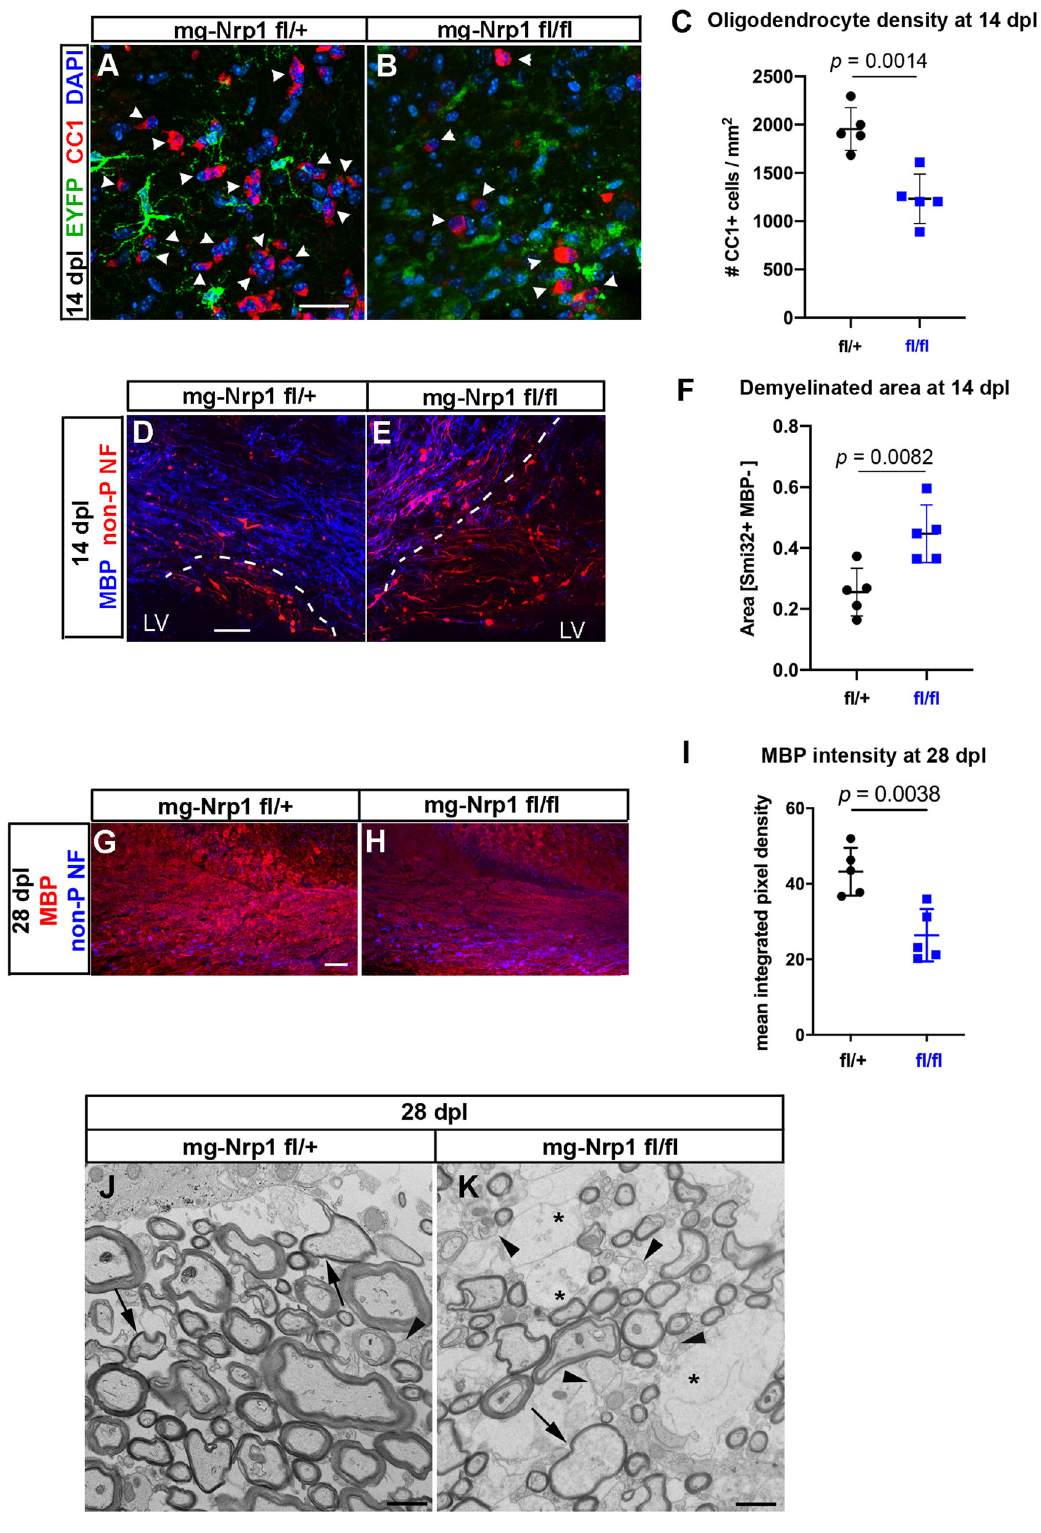
There was a higher level of non-phosphorylated neuro fi lament in the cko, which is consistent with prolonged impairment of myelin repair. To examine the extent of myelin repair in more detail, we performed ultrastructural analysis of the lesioned corpus callosum of mg-Nrp1-cont and mg-Nrp1-cko mice at 28 dpl